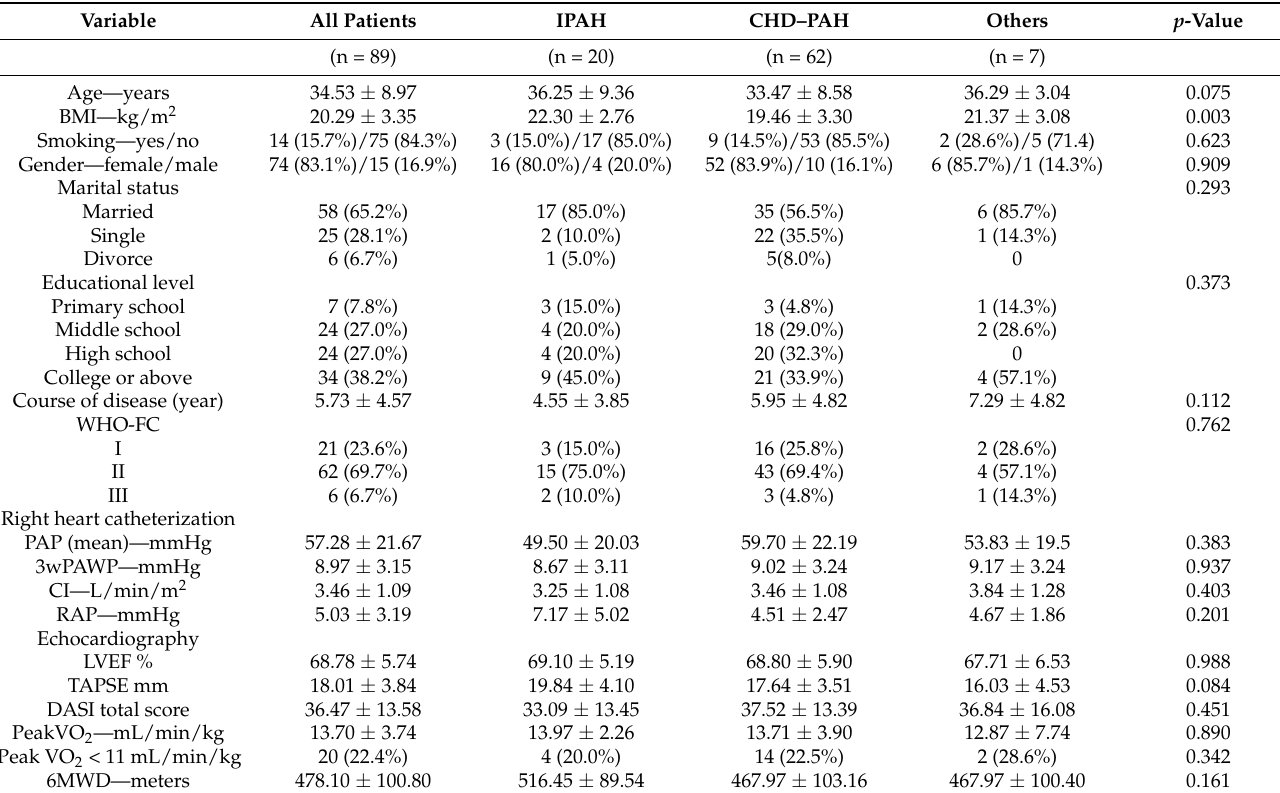
Table 1. Baseline demographic and clinical characteristics of the patients.